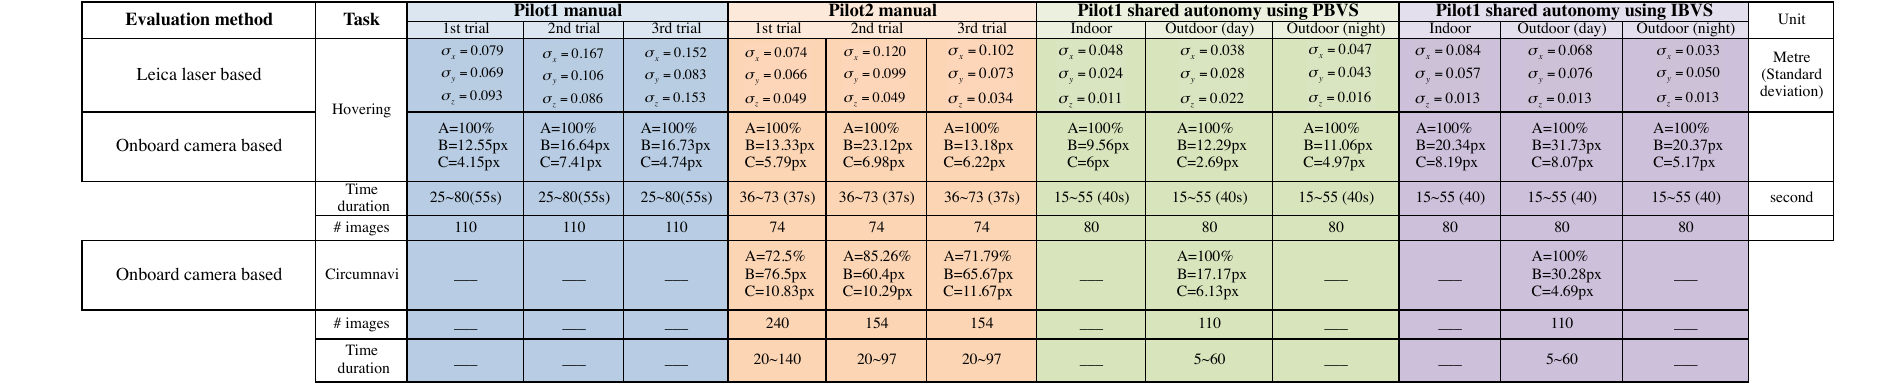
Figure 35. Performance evaluation of manual pilot and autonomous